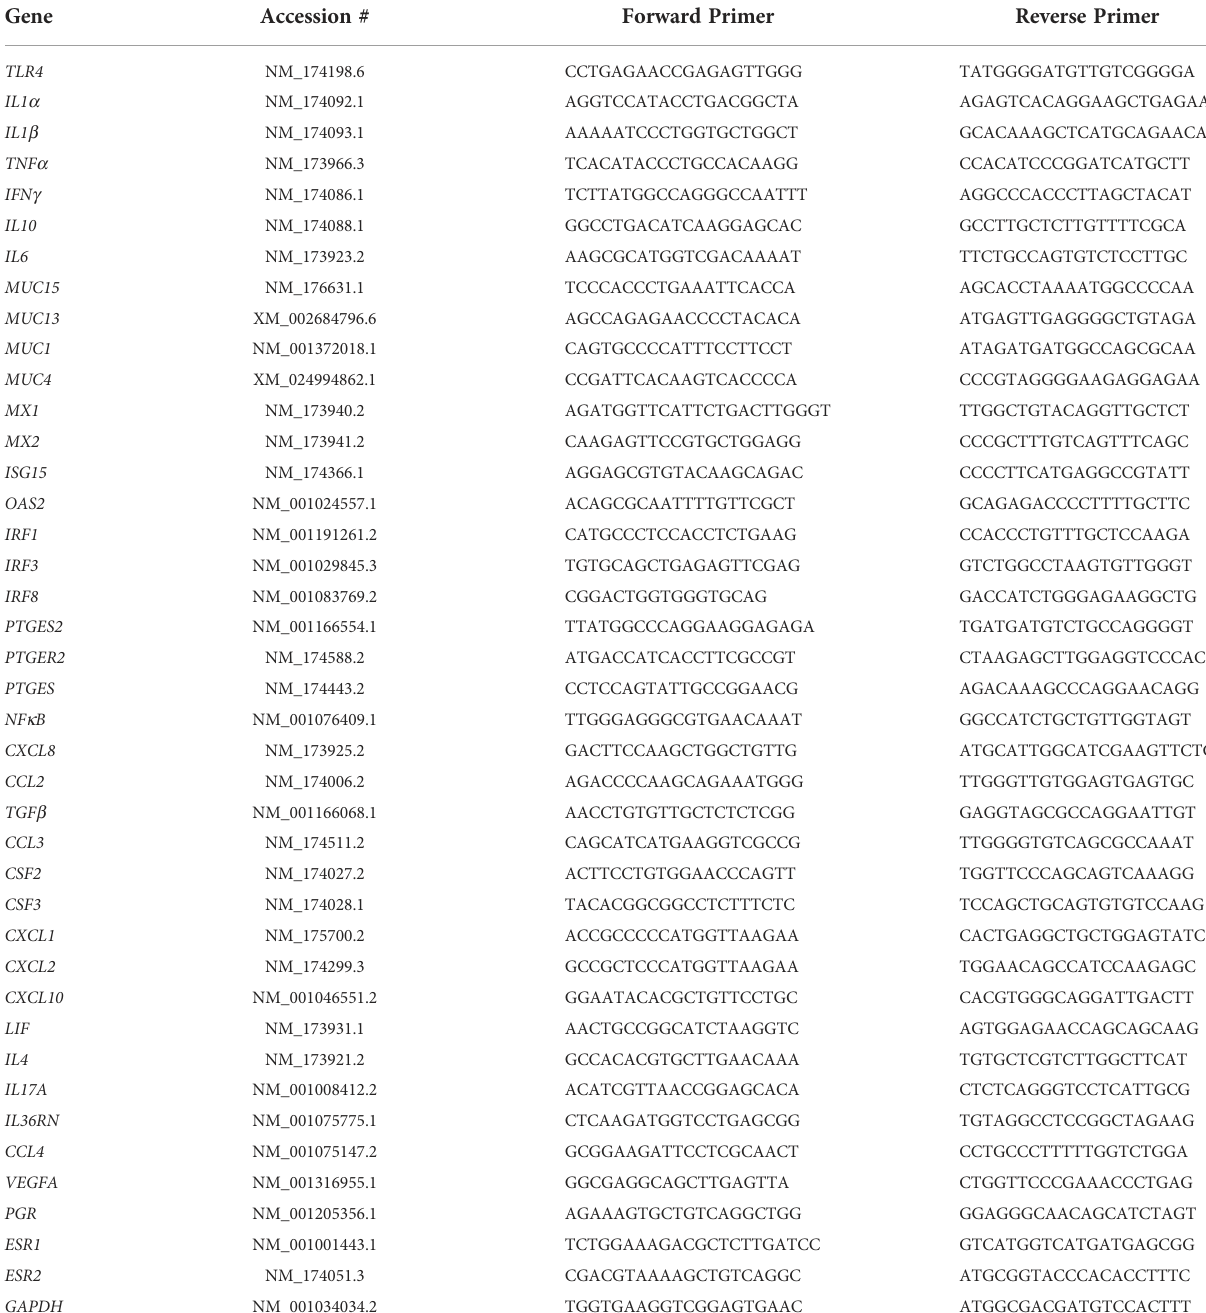
TABLE 1 Genes of interest and NCBI gene accession number with resulting forward and reverse primers for targeted RNA